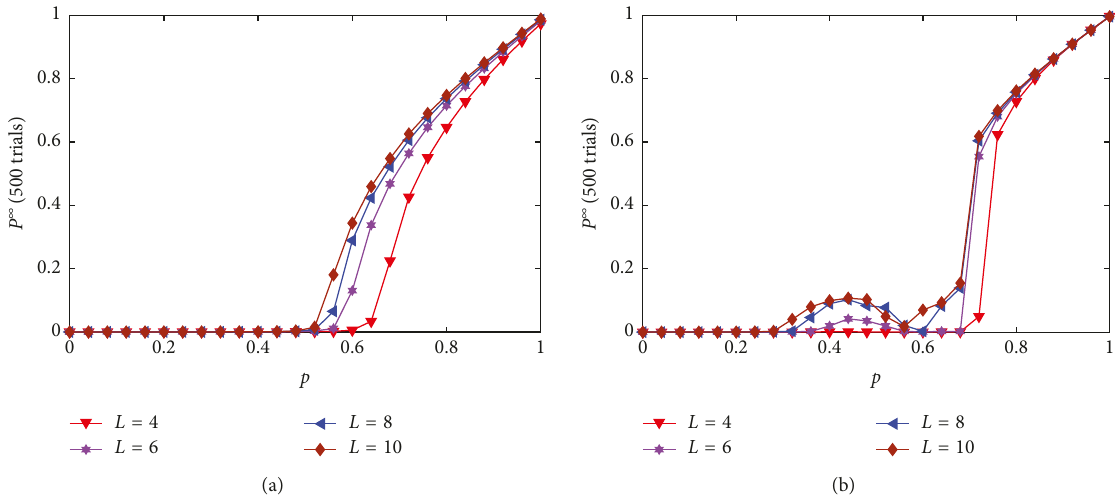
Figure 9: Impacts of L on the robustness of multipartite networks (size controlled by L ) each of which is subject to node attacks occurred to every partite set. For each network, we set n i � n j � 4 × 10 4 and p i � p j � 6/ n i . (a) Robustness of multipartite networks based on the network model M1. (b) Robustness of multipartite networks based on the network model M2.